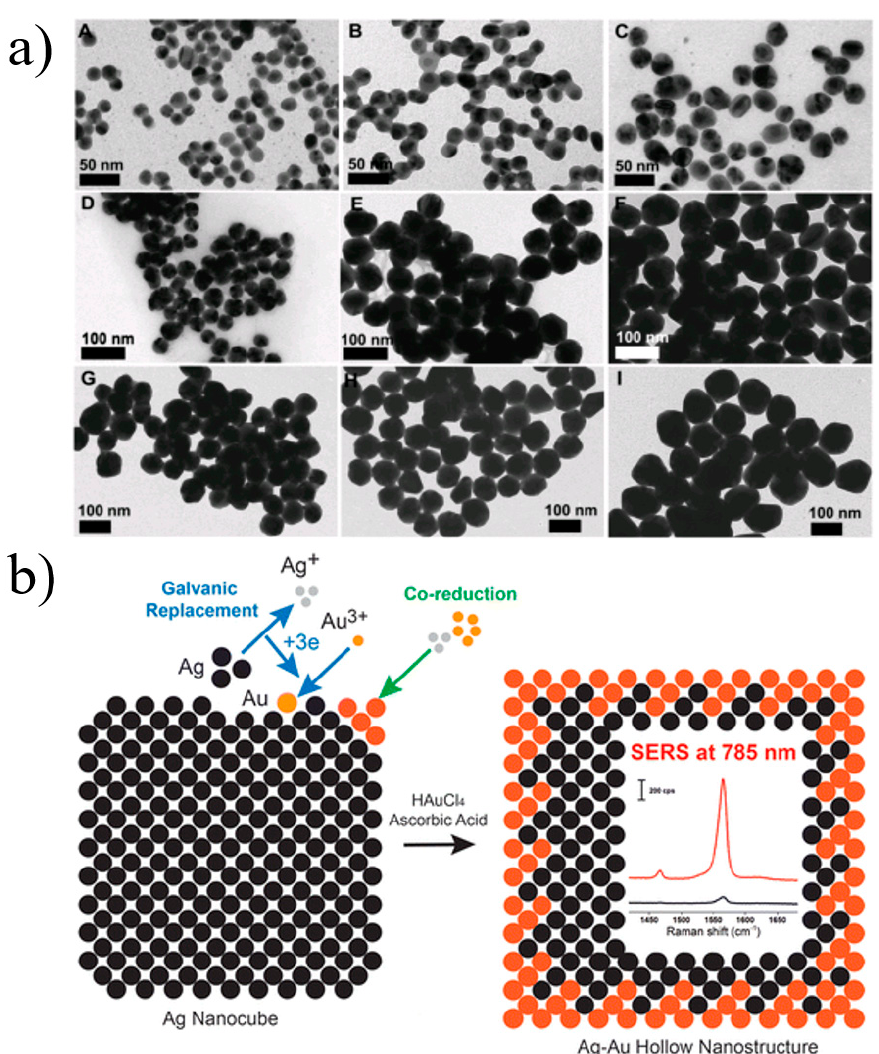
Figure 36. ( a ) TEM images of Au @ Ag core–shell nanospheres from Au NPs of di ff erent sizes. [( A – C ) 15 nm, ( D – F ) 32 nm, and ( G – I ) 55nm after 3 ( A , D , and G ), 5 ( B , E , and H ), and 10 ( C , F , and I